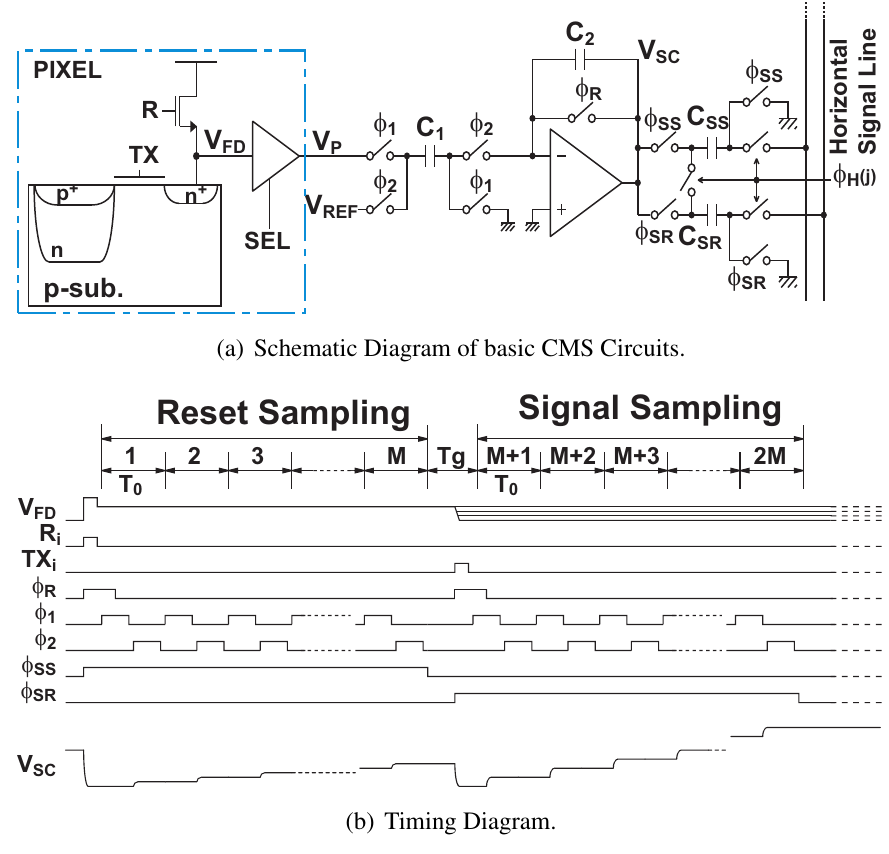
Figure 1. Schematic and Timing Diagrams of Implemented basic CMS